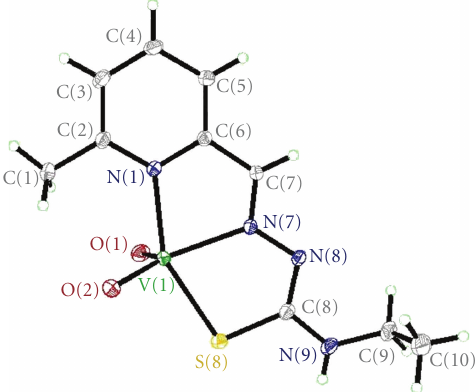
Figure 2: Structure of [VO 2 (mpETSC)] with numbering